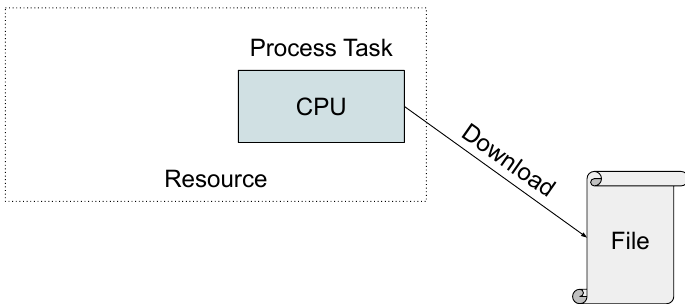
Figure 3. Execution flow of a write task on a computational resource.